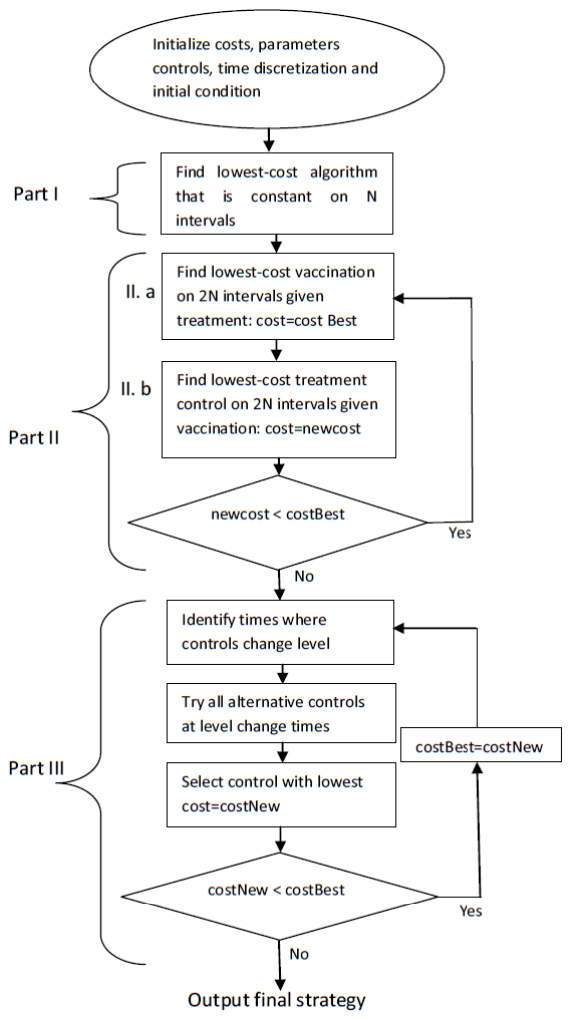
Figure 3. Algorithm’s flowchart to find near-optimal strategy